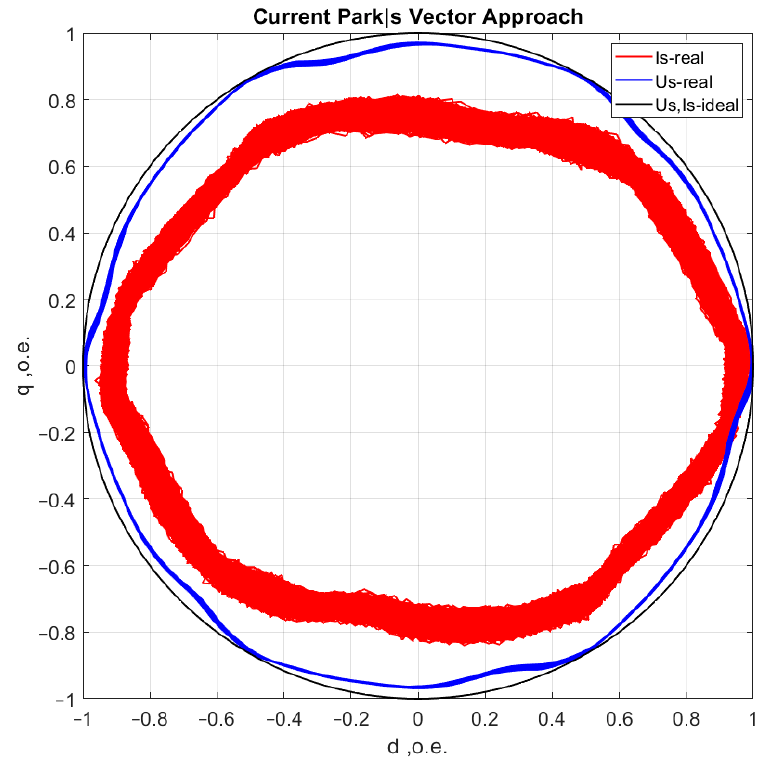
Figure 9. Motor operation with three shells in the inner bearing ring.